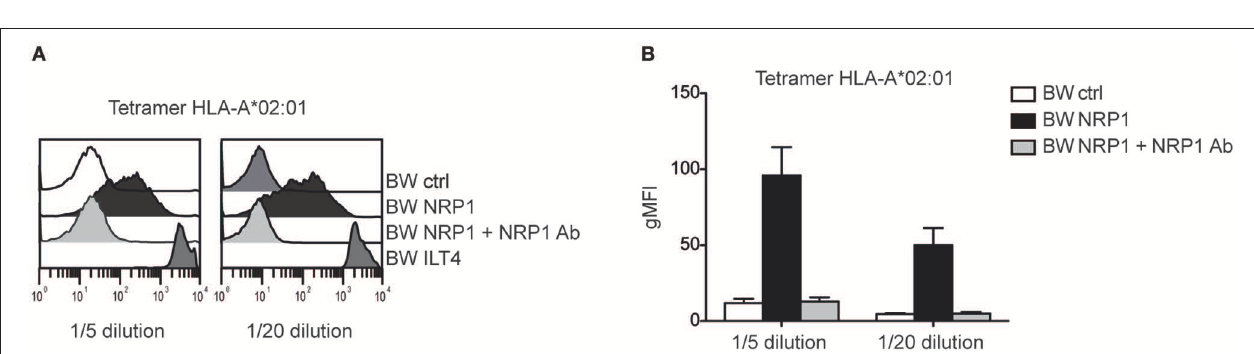
FIGURE 5 | The b1 region of neuropilin-1 is essential for the interaction with CSPs. (A) Schematic representation of wildtype (wt) NRP1 and seven deletion variants. (B) Flow cytometric analysis of BW cells expressing wildtype NRP1 and NRP1 deletion variants depicted in (A) using a polyclonal NRP1 antibody. (C) BW control cells (ctrl) and BW cells expressing wt-NRP1 or NRP1 deletion variants were probed with the indicated biotinylated rh-C4Bd, ih-C3d, and ih-iC3b molecules (20 µ g/ml each) followed by SA-PE and analyzed via flow cytometry. The data are from three independent experiments performed in triplicates. (D) Binding of an immunoglobulin fusion protein representing the CUB domain (a1a2) of NRP1 (rh-NRP1-CUB-Ig; 10 µ g/ml) and two differently generated fusion proteins representing the extracellular part (a1a2 and b1b2) of NRP1 (rh-NRP1-Ig (generated in house) and rh-NRP1-Ig (c.) (commercial); 10 µ g/ml each) to immobilized rh-C4Ad, rh-C4Bd and ih-C3d (465nM each) was assessed by ELISA. gMFI, geometric mean of fluorescence intensity; SEA, the SerGluAla C-terminal tripeptide represents a PDZ domain-binding motif.